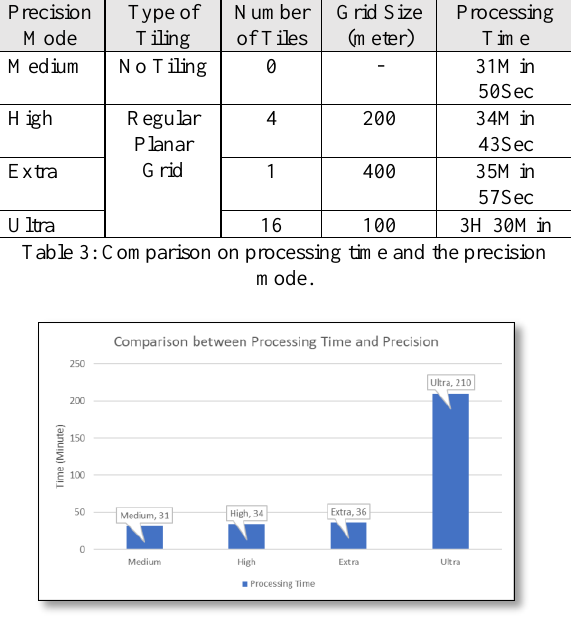
Figure 11: Comparison between processing time based on number of tiles.